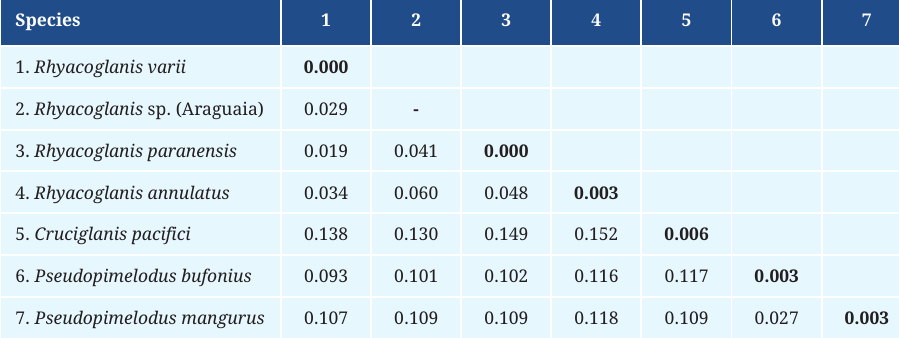
TABLE 3 | Interspecific and intraspecific genetic distances are based on the mitochondrial gene cytochrome c oxidase I (COI). Values are shown as proportions. Intraspecific distances are in